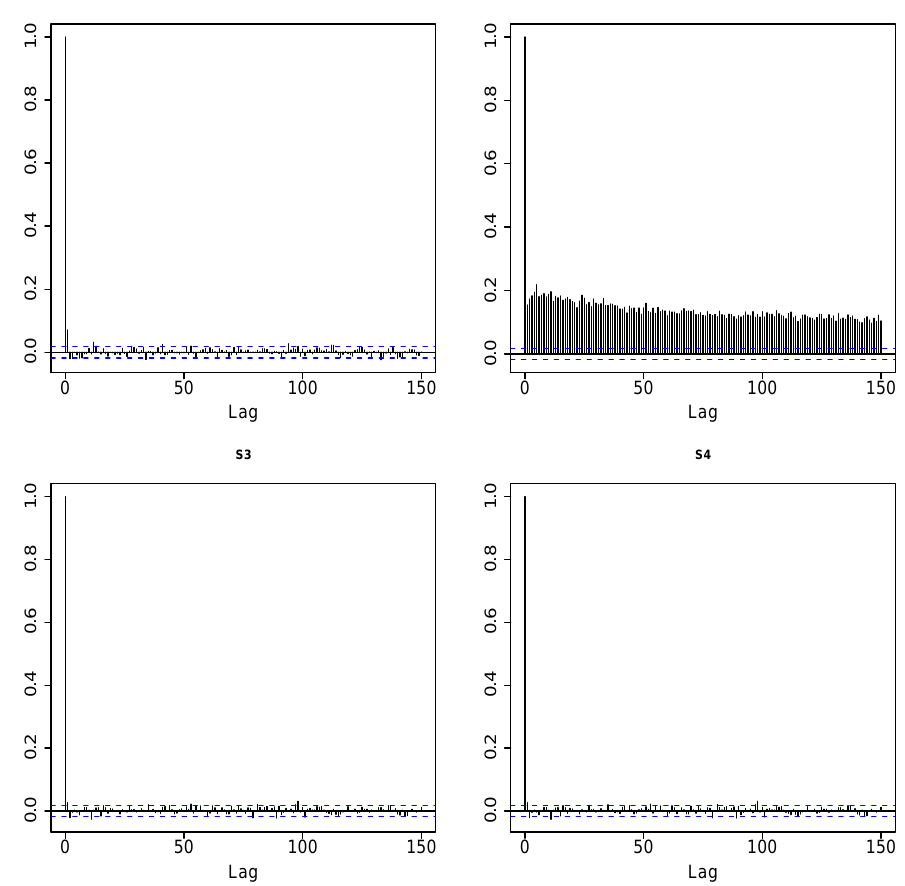
Figure 4. LP-correlogram: Sample autocorrelations of LP-transformed time series. The decay rate of the sample autocorrelations of YS 2 ( t ) appears to be much slower than the exponential decay of the ARMA process, implying possible long-memory